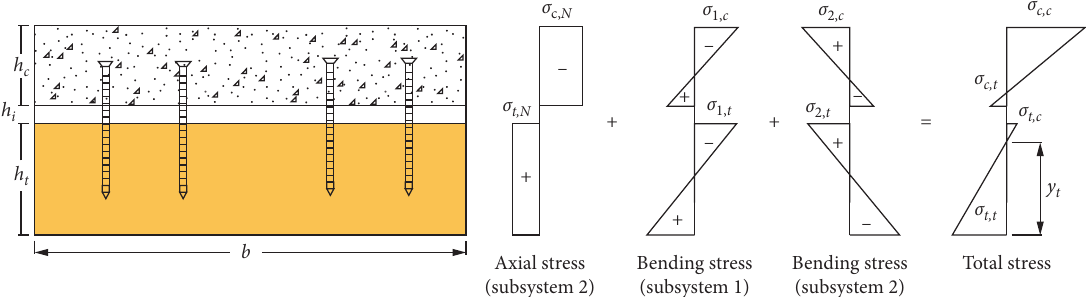
Figure 2: Stress distributions in the TCC